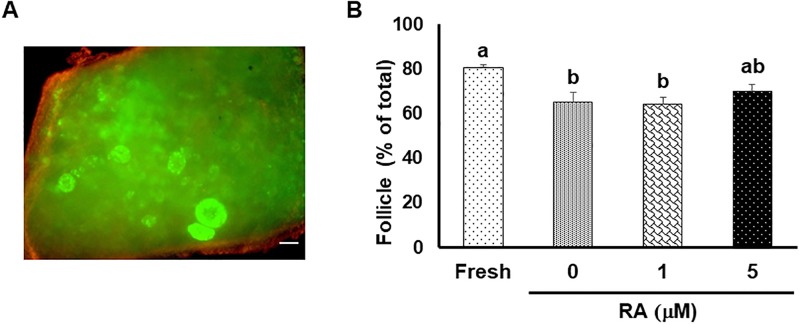
Influence of RA on follicle viability.(A) Fluorescent staining with calcein-AM/ethidium homodimer-1 after culture in 5 μM retinoic acid for 7 d. Green fluorescence indicates viable follicles/cell. Bar = 100 μm. (B) Mean (± SEM) of follicle viability in freshly collected cat ovarian tissue and cortical pieces cultured for 7 d. Different letters indicate significant (P < 0.05) differences.